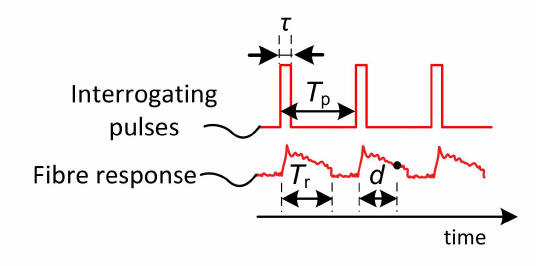
Figure 3. Interrogating optical pulse sequence and the fiber backscattering